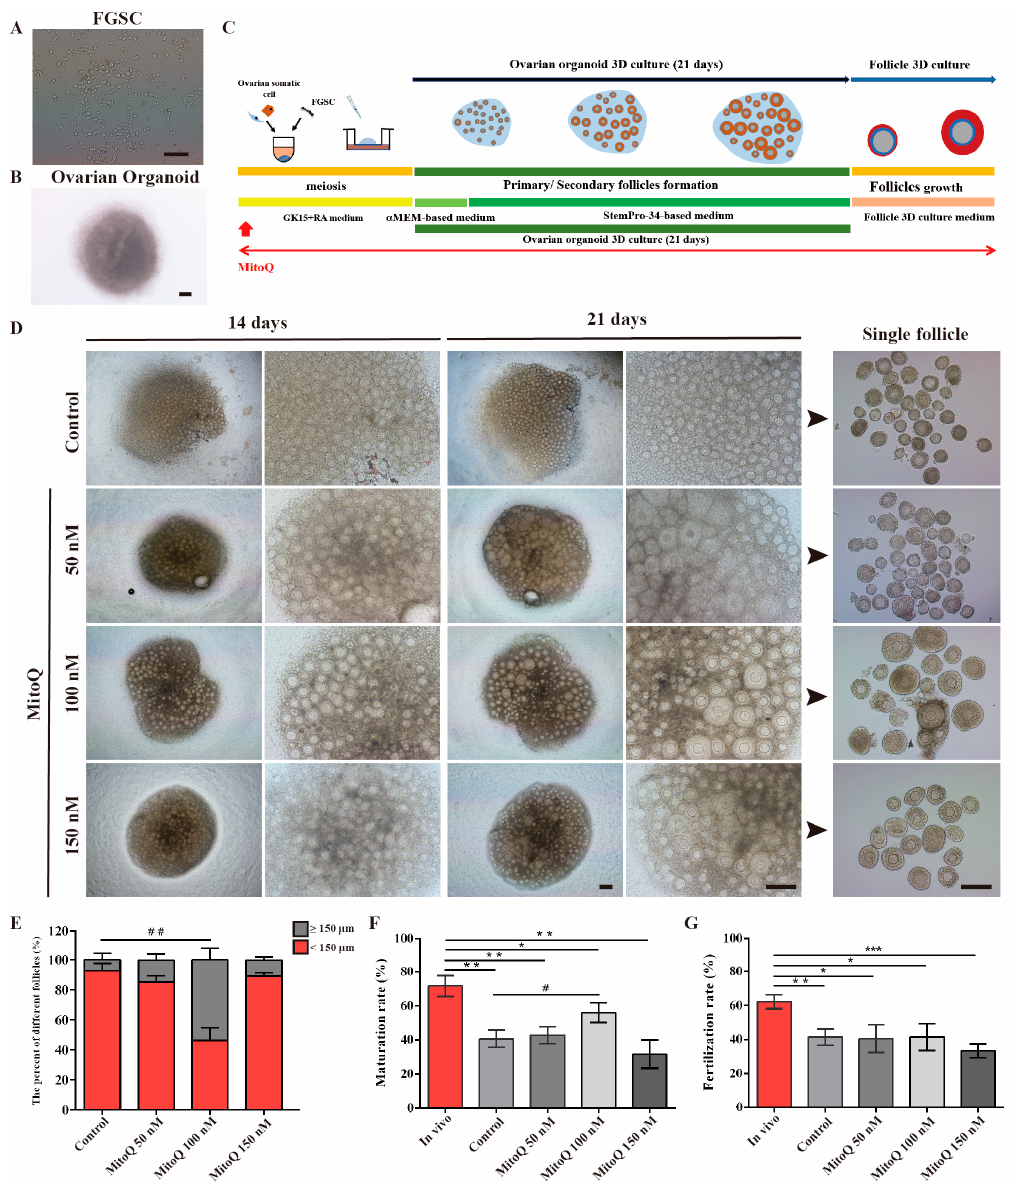
Figure 1. MitoQ promotes follicle growth and maturation in vitro. ( A ) FGSCs colony morphology. Scale bar, 200 μ m. ( B ) Representative images of ovarian organoids at day 3. Scale bar, 100 µ m. ( C ) Schematic diagram of the generation of ovarian organoids. ( D ) Representative images of organoids differentiated from FGSCs at 14 and 21 days of culture (Left). Scale bar, 200 µ m. Representative images of single follicles isolated from ovarian organoids (right). Scale bar, 200 µ m. ( E ) Quantification analyses of different sizes follicles ( n = 3), error bars indicate SD. ## p < 0.01, vs. control group. ( F ) Quantification analyses of IVM rate ( n = 3). In vivo: in vivo-derived oocytes. Error bars indicate SD. * p < 0.05, ** p < 0.01, vs. in vivo group, # p < 0.05, vs. control group. ( G ) Quantification analyses of fertilization rate ( n = 3). In vivo: in vivo-derived oocytes. Error bars indicate SD. * p < 0.05, ** p < 0.01, *** p < 0.001, vs. in vivo